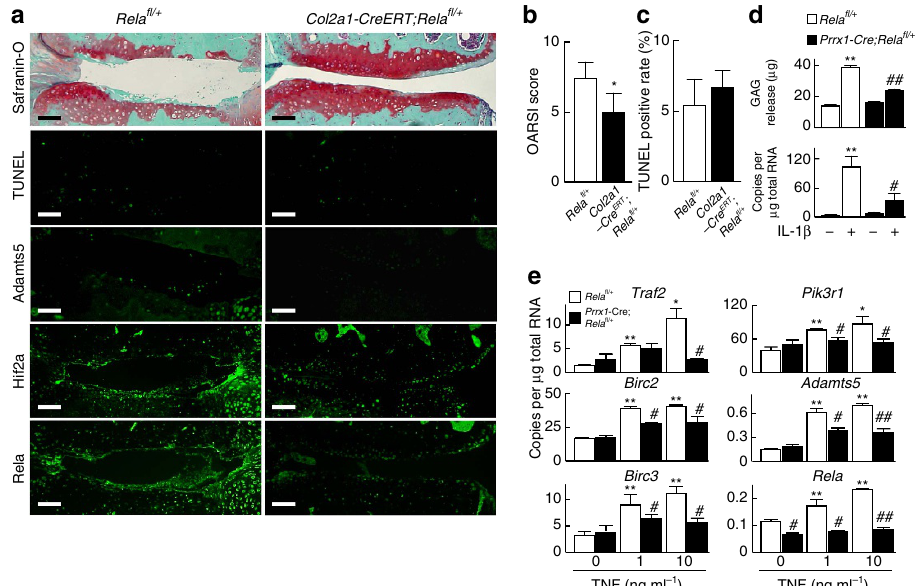
Figure 7 | Suppression of OA development by heterozygous knockout of Rela. ( a ) Safranin-O, TUNEL staining and immunofluorescence of Adamts5, Hif2a and Rela in knee joint cartilage of Rela fl/ þ and Col2a1-Cre ERT ;Rela fl/ þ littermates at 8 weeks after surgery to induce OA. n ¼ 15 and 14, respectively. Scale bars, 100 m m. ( b ) OARSI score of OA development. Data are expressed as the means ± s.d. of five mice per group. * P o 0.05 versus Rela fl/ þ mice; Welch’s t -test. ( c ) Rate of TUNEL-positive cells in articular cartilage. Data are expressed as the means ± s.d. of five mice per group. ( d ) Amount of glycosaminoglycans released into the medium determined by the dimethylmethylene blue assay during 4 days of culture of femoral heads obtained from Rela fl/ þ and Prrx1-Cre; Rela fl/ þ littermates ( n ¼ 4 for each) with or without interleukin-1 b treatment (top), and the mRNA level of Adamts5 in the femoral heads (bottom). Data are expressed as the means ± s.d. of three wells per group. ** P o 0.01 versus Rela fl/ þ mice without interleukin-1 b treatment; Student’s t -test. # P o 0.05, ## P o 0.01 versus Rela fl/ þ mice with interleukin-1 b treatment; Student’s t -test. ( e ) mRNA levels of the target genes in primary chondrocytes obtained from Rela fl/ þ and Prrx1-Cre; Rela fl/ þ mice (P5) with or without TNF treatment. Data are expressed as the means ± s.d. of three wells per group. * P o 0.05, ** P o 0.01 versus Rela fl/ þ mice without TNF treatment; Student’s t -test. # P o 0.05, ## P o 0.01 versus the respective Rela fl/ þ control treated with the same dose of TNF; Student’s t and then mated with Rela fl/fl mice. Sequences of the primers used for genotyping are shown in Supplementary Table 1. Histology . Haematoxylin and eosin (H&E) staining was performed according to standard protocols after fixation in 4% paraformaldehyde/PBS. For immunohis- tochemistry, the sections were incubated with antibodies against Rela (1:100; #8242, Cell Signaling Technology, Danvers, MA), I k B a (1:100; sc-371, Santa Cruz